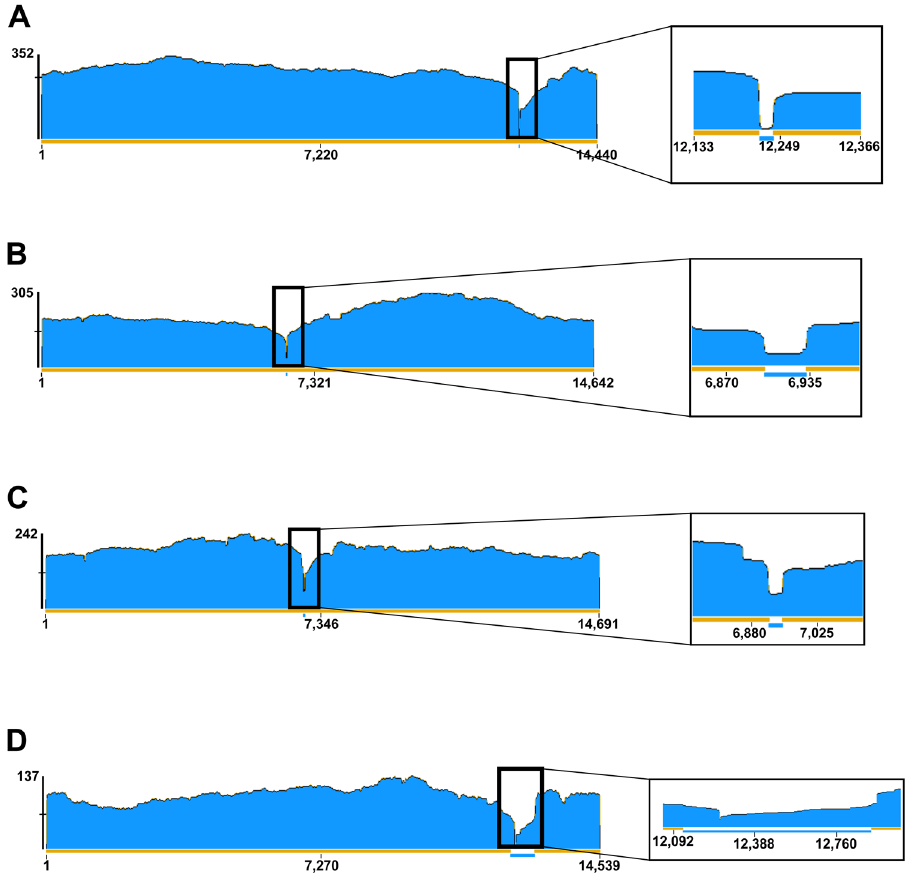
Figure 2. Sequence coverage analysis. To investigate if read coverage was the reason for the increased amount of nucleotide differences observed between our ONT assemblies and the Illumina references, we mapped our ONT reads against the Illumina assemblies. The read-depth coverage histogram generated by Geneious Prime is depicted for each sample of concern , Argas africolumbae JM2 ( A ), Amblyomma tholloni 1 ( B ), Rhipicephalus zambeziensis ( C ), and Ixodes rubicundus ( D ). The inset panels show a zoomed in look at the lower coverage areas. Nucleotide positions across the mitogenome are indicated. The max read-depth coverage is indicated to the left of the histogram. The gold and blue bars at the bottom of the coverage histogram indicate positions above ×60 and below ×60 read coverage,